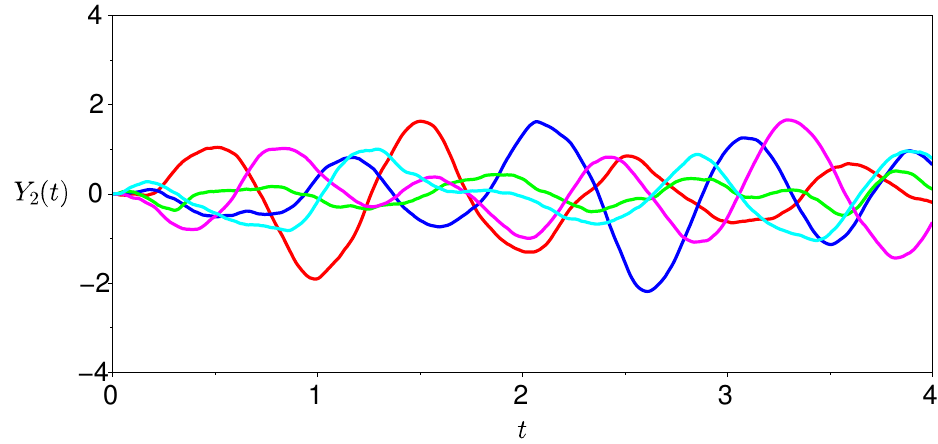
Figure 2. Five sample paths generated by Y 2 = { Y 2 ( t ) : 0 ≤ t ≤ 4 } , where Y 2 is given in (10).